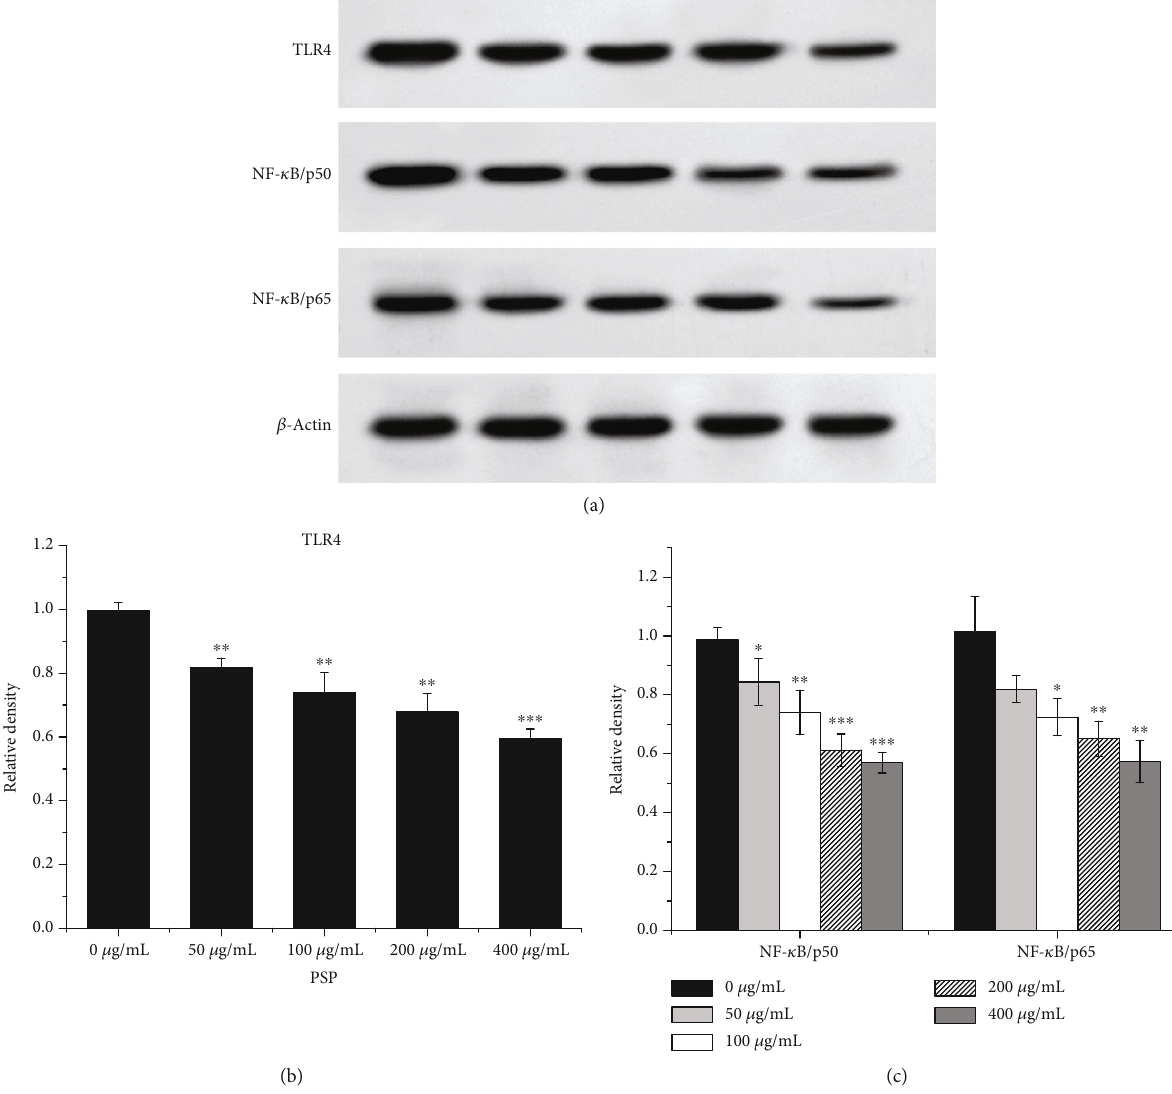
Figure 6: Expression of TLR4/NF- κ B signaling pathway protein in Eca109 cells. (a) Western blot analysis of TLR4, NF- κ B/p50, and NF- κ B/p65 protein expression in Eca109 cells. (b) Quantitative results of (a), compared with the control group, ∗ p < 0 : 05 , ∗∗ p < 0 : 01 , and ∗∗∗ p < 0 : 001